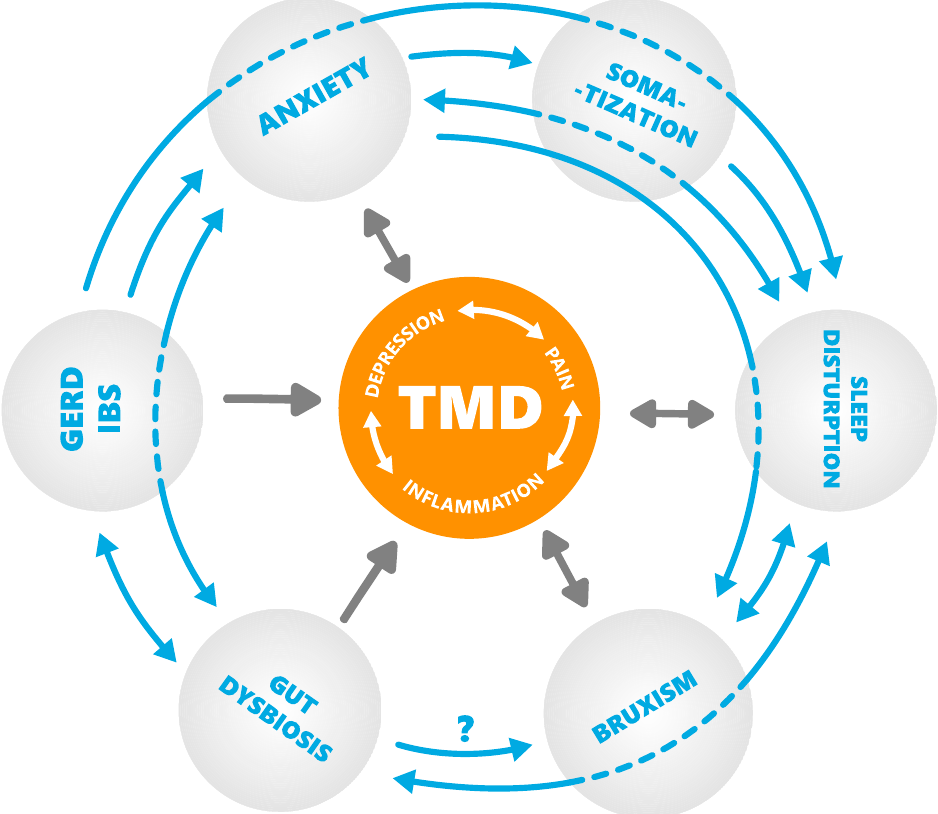
Figure 5. Vicious cycle of chronic diseases leading to chronic temporomandibular disorders (own resources).